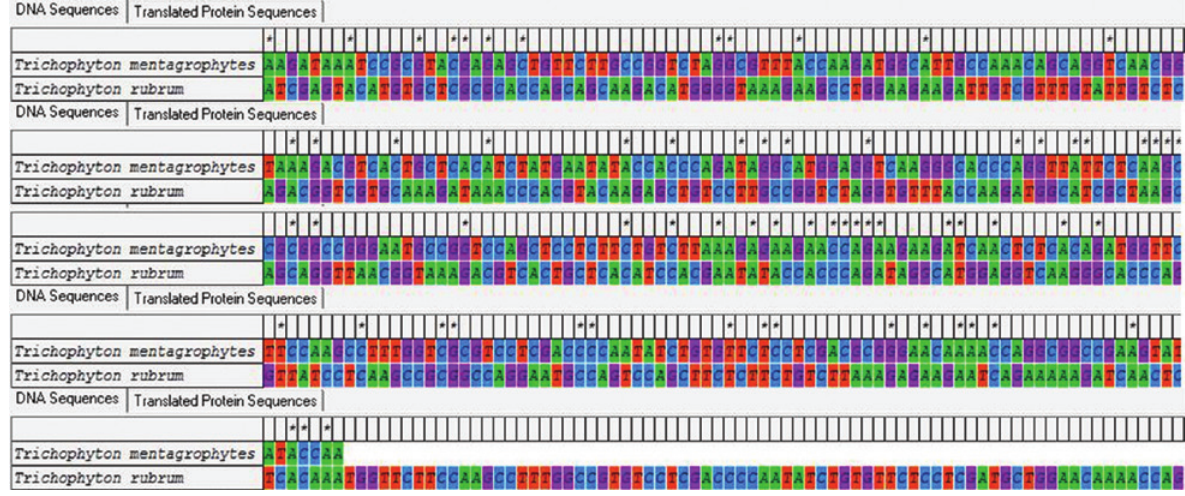
Figure 8: Alignment of the chitin synthase gene 1 ( chs gene 1) of Trichophyton mentagrophytes and Trichophyton rubrum by the boot- strapped ClustalW program in MEGA 4 and its phylogenetic tree constructed using the sequences of ( chs gene 1) by the bootstrapped N-J plot used for the antifungal susceptibility test (sequences of the strains were obtained from NCBI